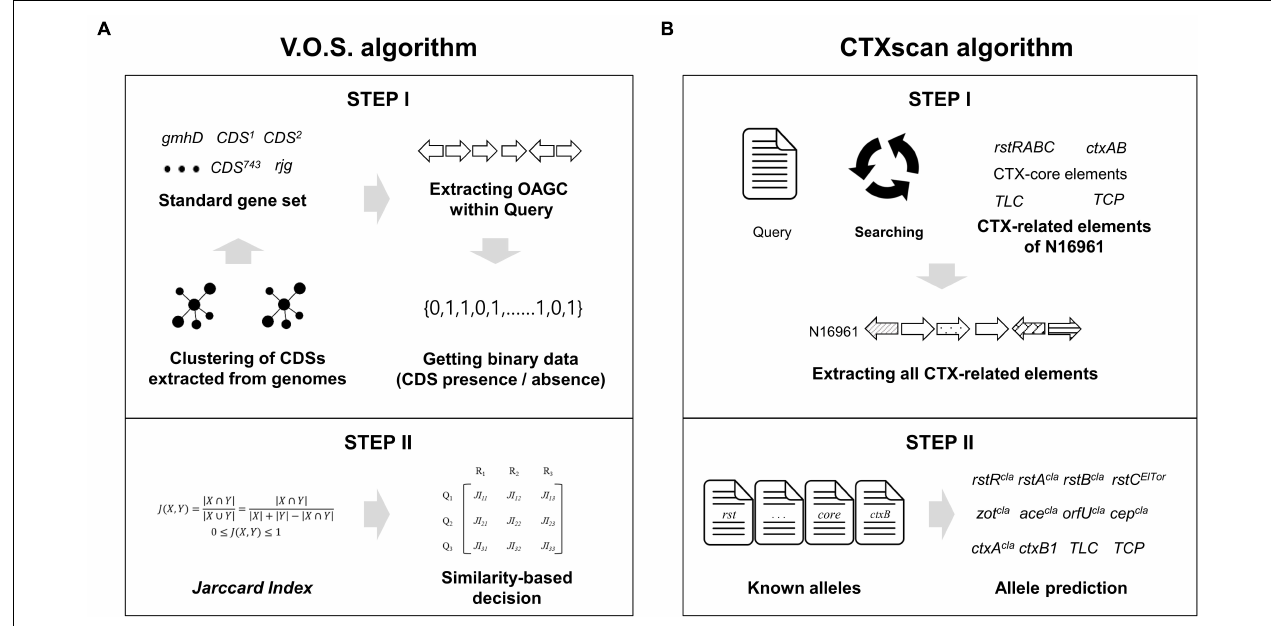
FIGURE 1 | Schematic diagram of the V.O.S. and CTXscan algorithms. (A) All the CDS of the OAGC were extracted from the V. cholerae genome dataset, and clustering was performed to create a standard gene set. To create a representative binary vector containing information on whether CDS is present or absent, the USEARCH program was used. Finally, the serogroup type was determined by comparing JI between a binary vector of the query and representative. (B) To extract the CTX-related elements from the query genome, the known prophage gene contents of N16961 were used. The extracted elements were compared against known alleles previously reported in other studies. The phage type prediction was performed based on sequence